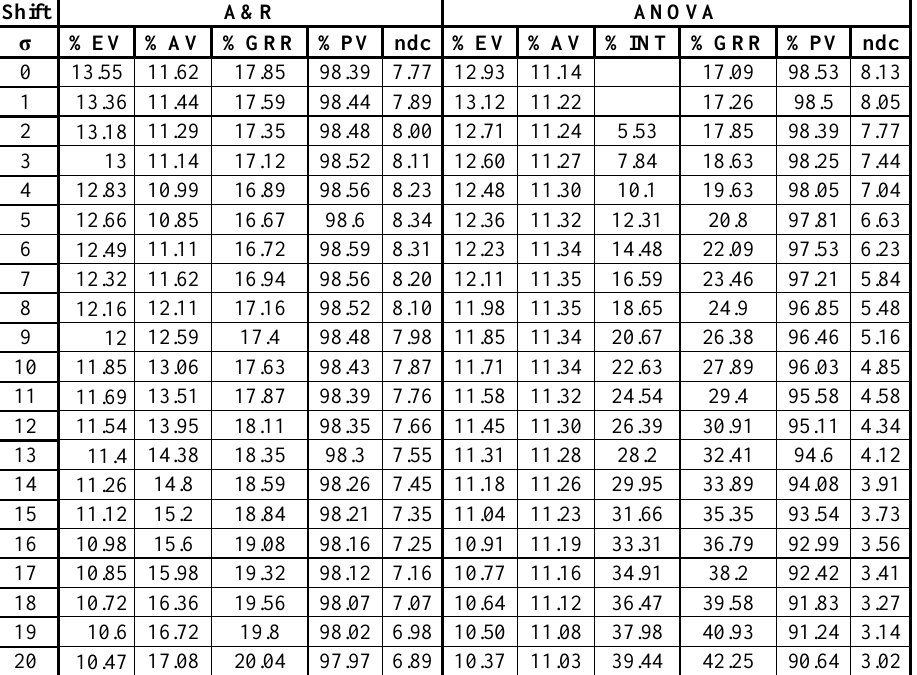
Table 3 Results of Simulation 2 for A&R and ANOVA methods. Shift A&R